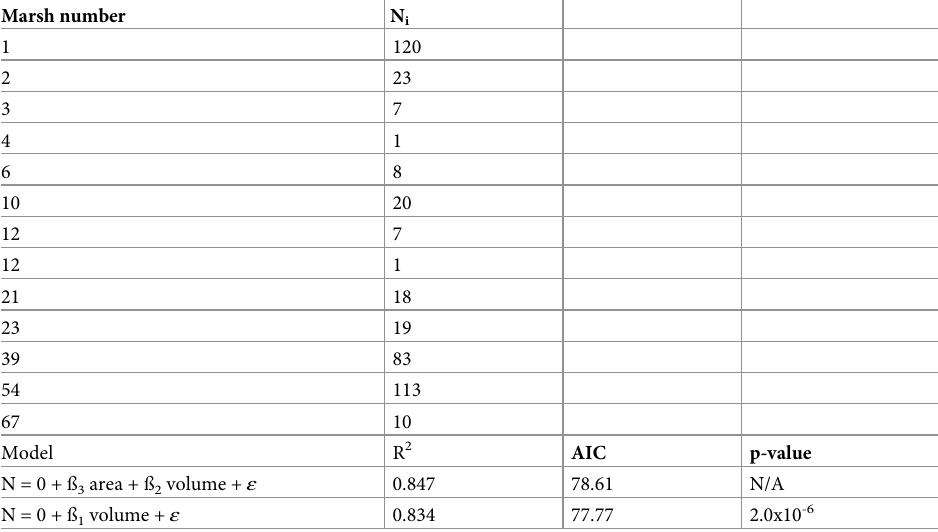
Table 2. Amargosa vole subpopulation sizes (N i ) at 14 well-studied marshes and best-fitting regression model of N i on water depth x patch